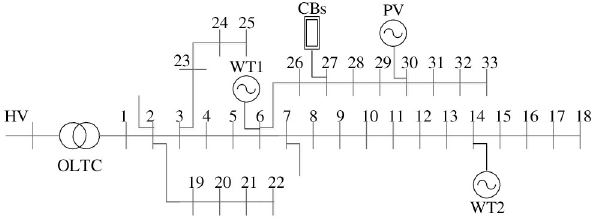
Fig 2. 33-node active distribution